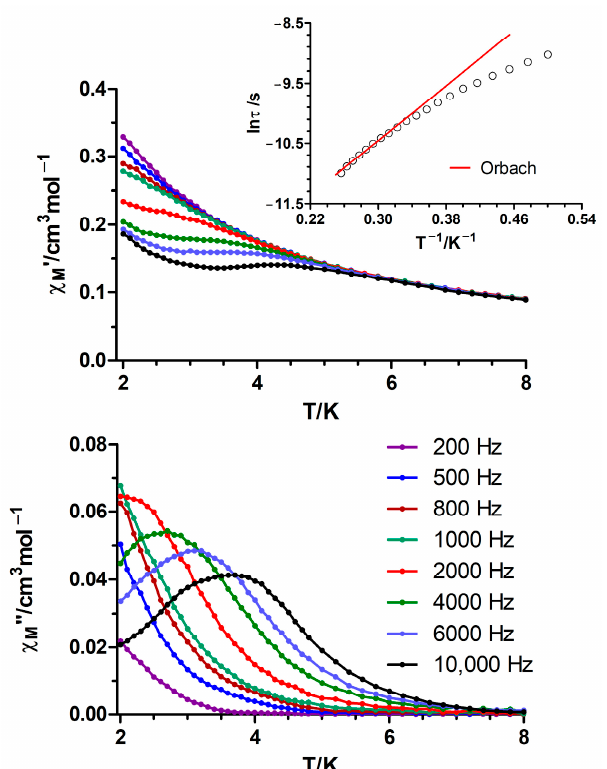
Figure 6. Temperature dependence of the in-phase ( top ) and out-of-phase ( bottom ) components of the ac susceptibility for 1 under an external field of 1000 Oe (the susceptibility values are given per Nd(III) ion). Inset: fitting of the relaxation times at each temperature (black circles) to Orbach relaxation modes (red line).